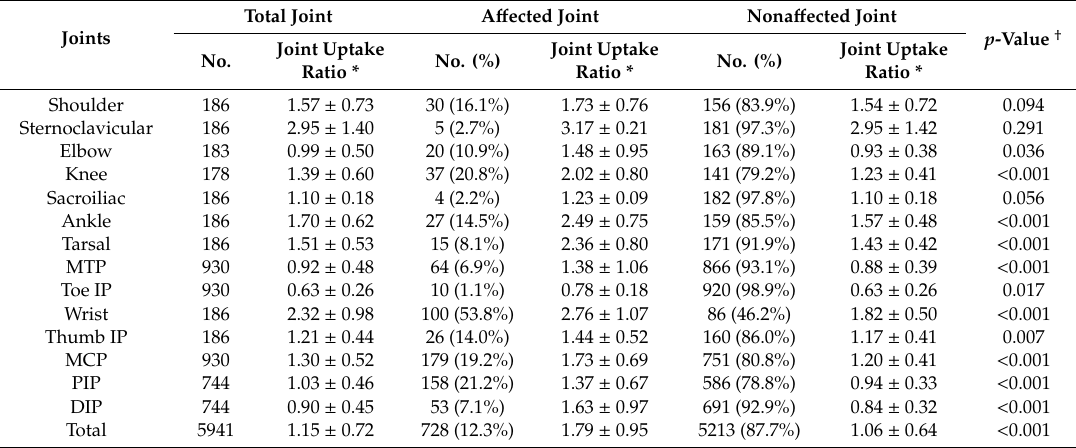
Table 1. The proportions and joint uptake ratios of a ff ected and nona ff ected joints in the 93 enrolled